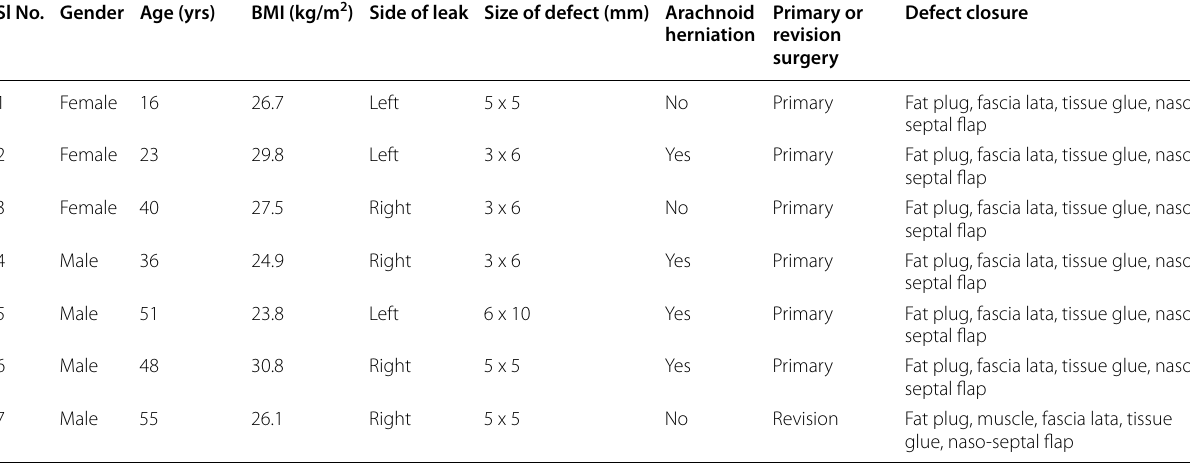
Table 1 Patients presentation with size and site of defect and treatment employed Sl No. Gender Age